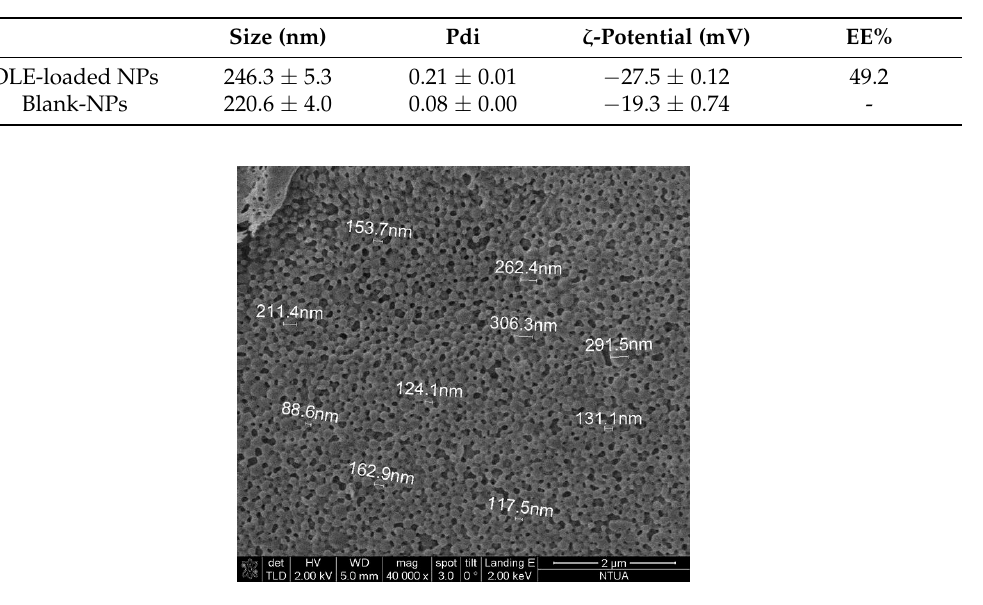
Figure 4. Scanning Electron Microscopy (SEM) image of PLA nanoparticles loaded with oil leaves extract (OLE-loaded NPs).